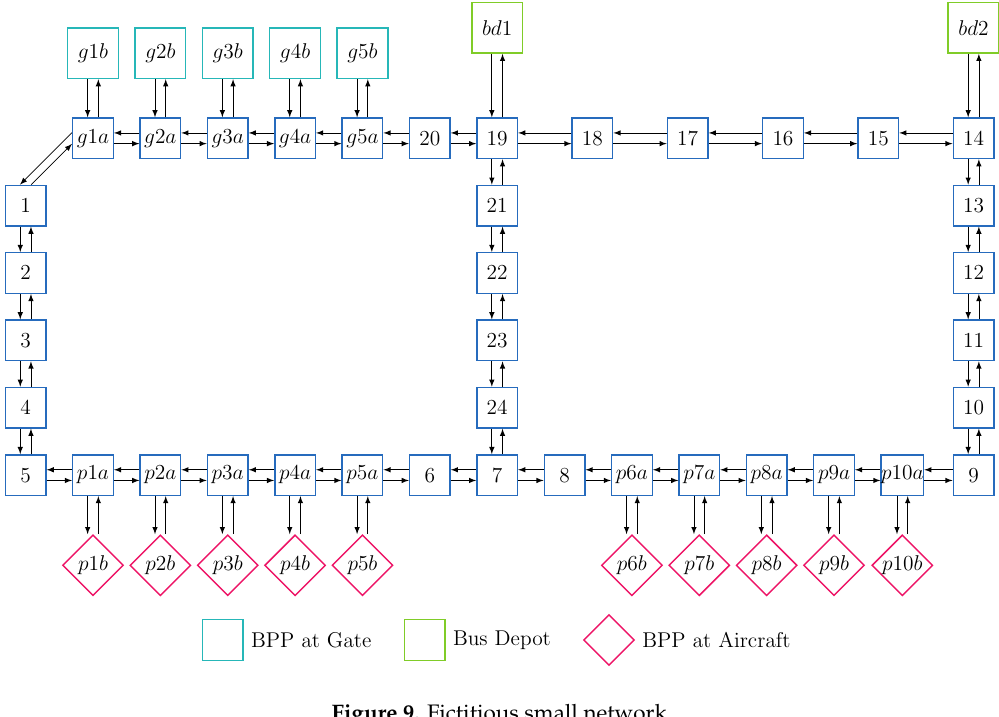
Figure 9. Fictitious small network. Table 2. Candidate nodes and links for the wireless charging infrastructure.